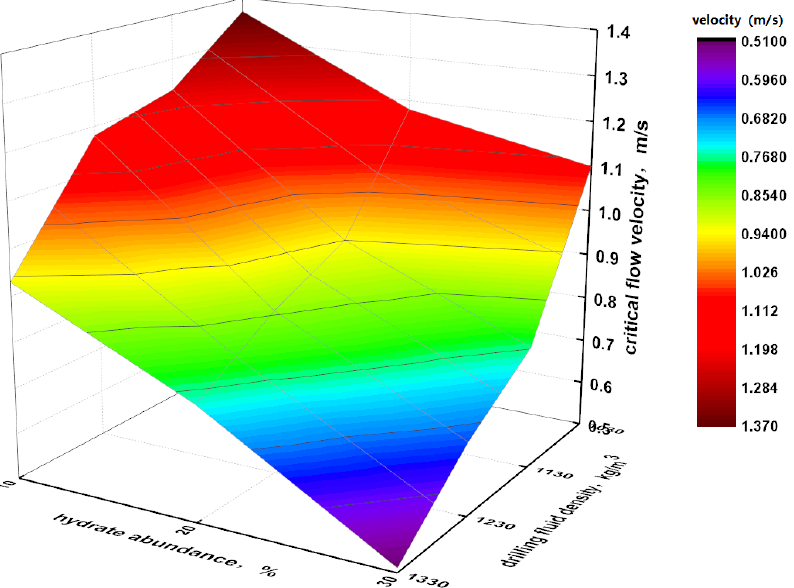
Figure 10. The critical flow velocity plate of different hydrate abundance and drilling fluid density under right-angle expansion.